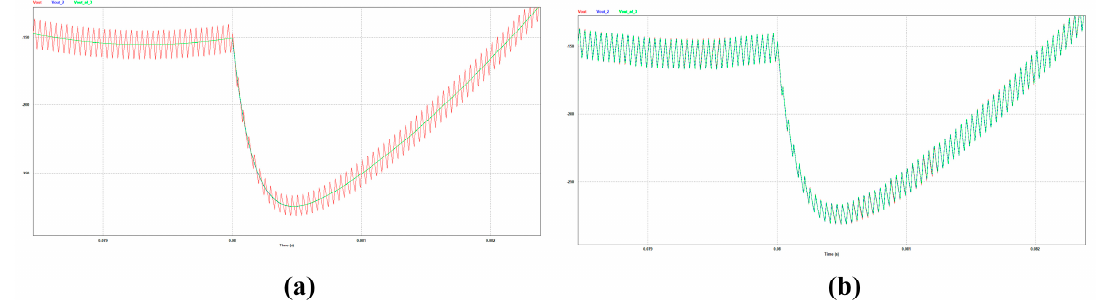
Figure 6. Magnified output voltage waveforms of equivalent model of ( a ) conventional d-q model and ( b ) the presented plant model considering unipolar SPWM in synchronous rotating frame.